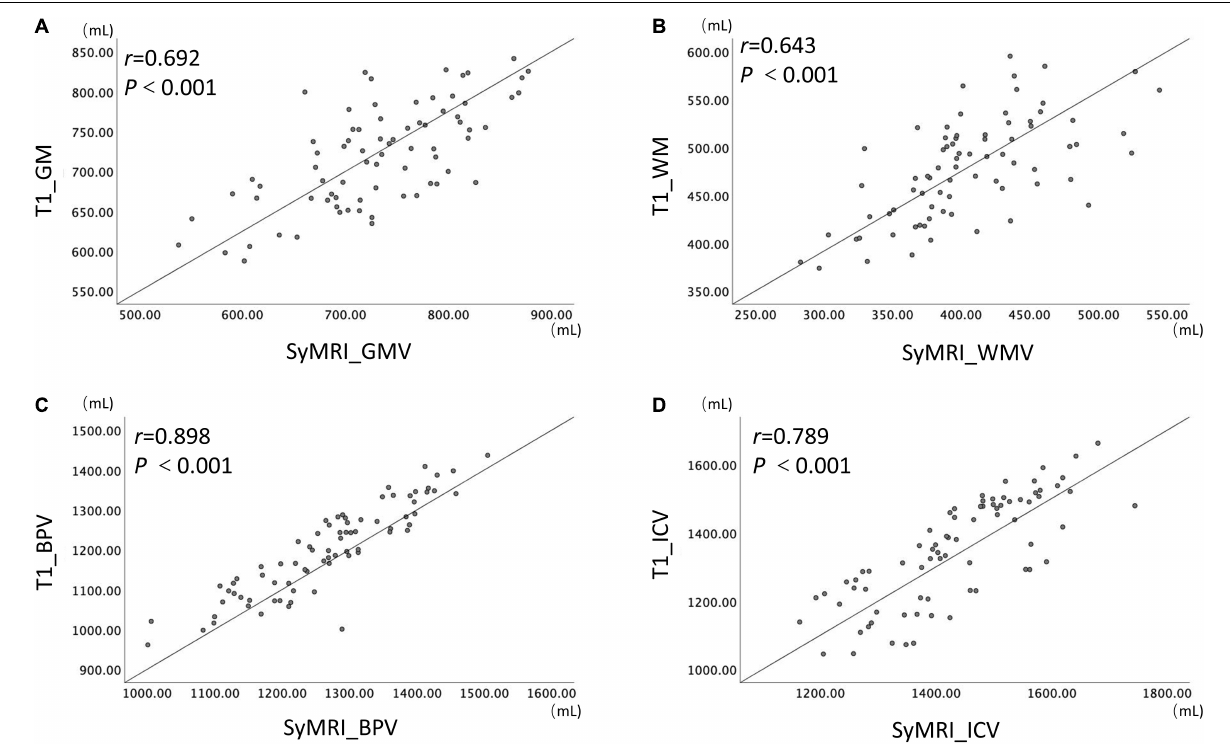
FIGURE 2 | The results of correlation analysis of the SyMRI and cT1w MRI